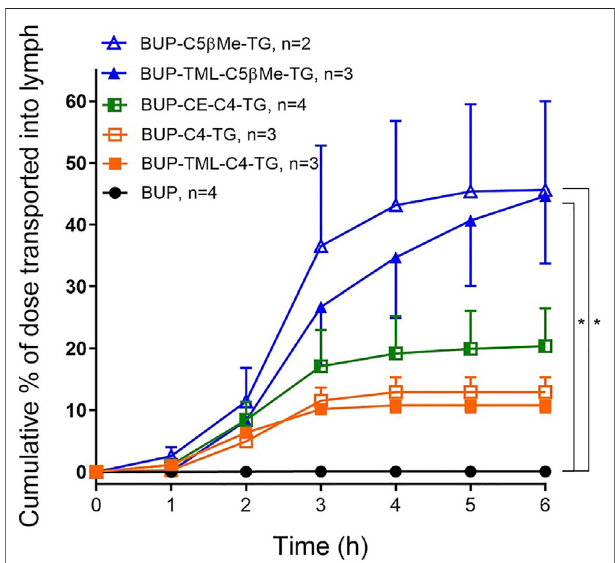
FIGURE 4 | Cumulative lymphatic transport of total BUP related derivatives (% of administered dose) versus time in anaesthetised, mesenteric lymph duct cannulated rats following intraduodenal infusion of formulations from 0 to 2 h. Formulations contained 50 µg of BUP or prodrugs, dispersed in 40 mg oleic acid, 25 mg Tween 80 and 5.6 ml PBS. Data are presentedasMean±SEMwhen n =3or4(aslabelledforindividualgroups)or as Mean ± Range in the case of BUP-C5bMe-TG when n = 2. * indicates statistically signi fi cantly higher lymphatic transport of BUP-C5bMe-TG